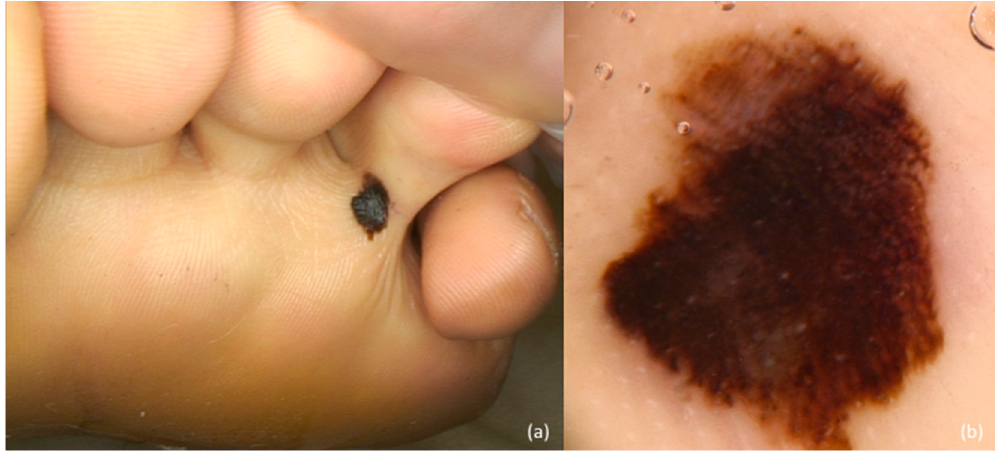
Figure 3. Plantar melanoma. Clinical presentation ( a ) reveals a black irregular macule. Dermoscopy ( b ) shows a parallel ridge pattern and structureless dark brown and black areas.